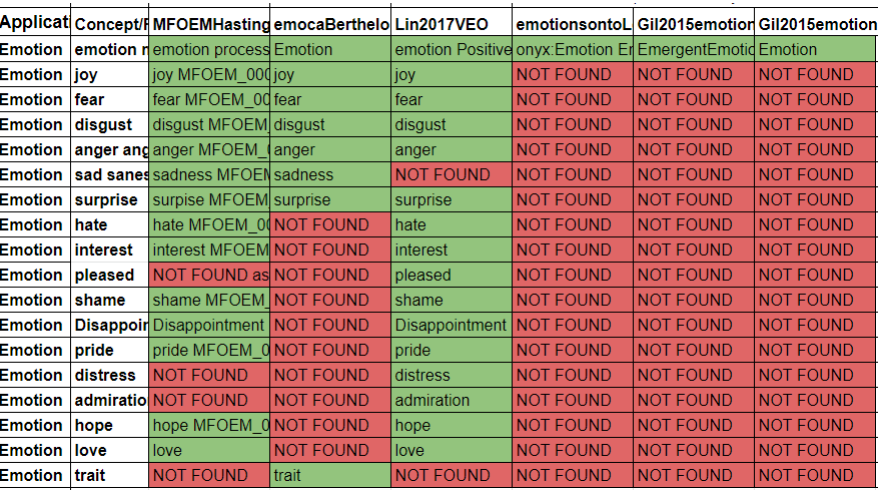
Figure 3. Emotion gold dataset: knowledge extraction from emotion ontologies that highlight the need to collect and integrate knowledge from complementary emotion ontologies. Table 2. Subset of mapping hormones and neurotransmitters to existing knowledge bases to demon- strate the difficulty to reuse only one knowledge base. Legend: * means that we use rdfs:seeAlso since the concepts are similar but might not be an equivalent